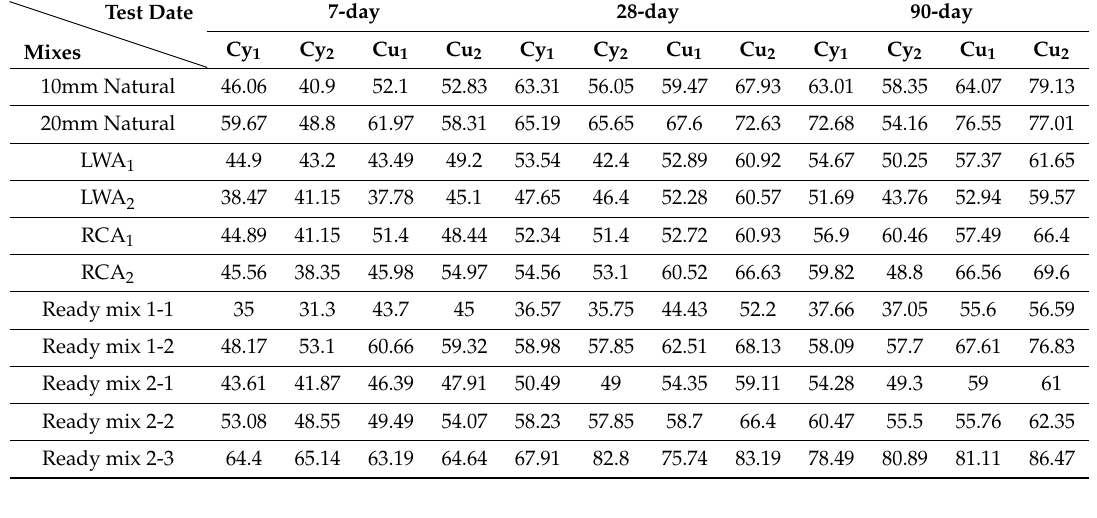
Table 7. Summary of compressive strength for di ff erent concrete mixes at 7th, 28th, and 90th day.